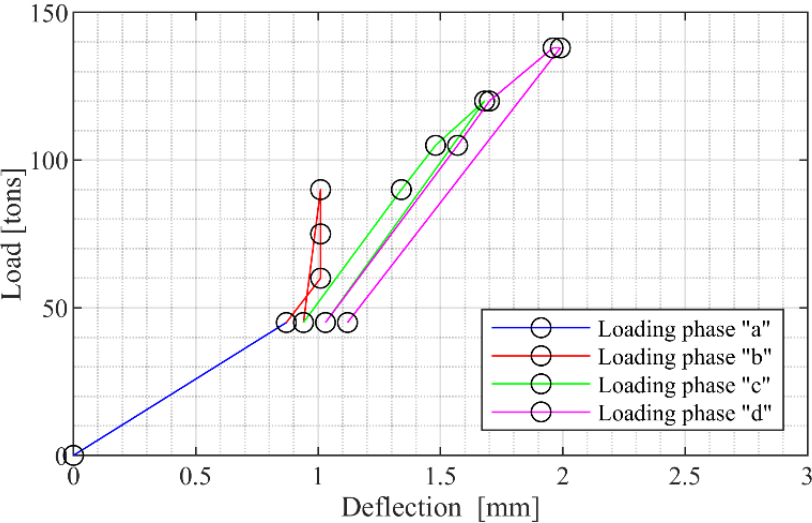
Figure 8. The response curve for the tested OT-slab bridge.